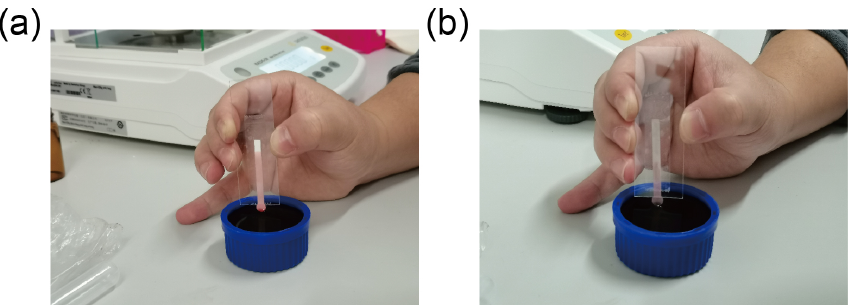
Figure A2. Water absorption experiments on nitrocellulose ( a ) and synthetic paper ( b ) test